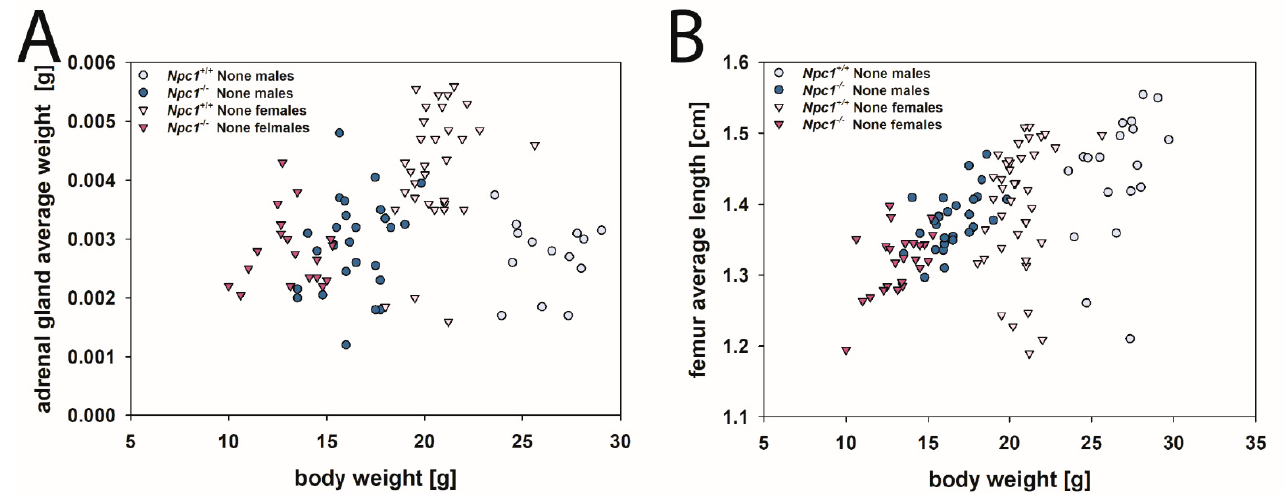
Figure 18. Organ weight of the adrenal glands ( A ) and femur length ( B ) in relation to body weight of individual Npc1 − / − and Npc1 +/+ mice of the None groups.